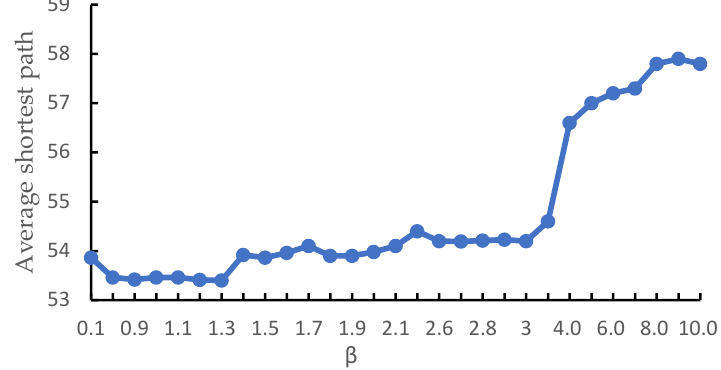
Figure 10. The effect of β on experimental results.